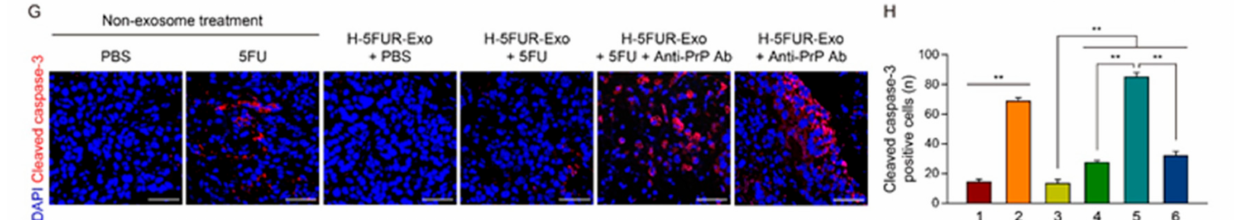
Figure 7. Effect of co-administration of anti-PrP antibody and 5FU in a murine xenograft model treated with exosomes secreted by hypoxic CRC cells. ( A ) Schematic illustration of SNU-C5/WT cells pretreated with/without H-5FUR-Exo in vivo subcutaneous transplantation and injection with PBS, 5FU, 5FU + anti-PrP antibody, and anti-PrP antibody. ( B ) Photographs of tumor growth in a murine xenograft mouse model. ( C ) Quantification of tumor size in each group ( n = 6). ( D ) ELISA analysis of PrP C expression in sera isolated from a murine xenograft model ( n = 6). ( E ) Representative immunofluorescence staining analysis of Ki-67 (green) in colorectal cancer tissues. Scale bar = 50 µ m. ( F ) The graph shows Ki-67-positive cells in tumor tissues ( n = 3) ( G ) Representative immunofluorescence staining analysis of cleaved caspase-3 (red) in colorectal cancer tissues. Scale bar = 50 µ m. ( H ) The graph shows cleaved caspase-3-positive cells in tumor tissues ( n = 3). Data are presented as the mean ± SEM. * p < 0.05, ** p < 0.01